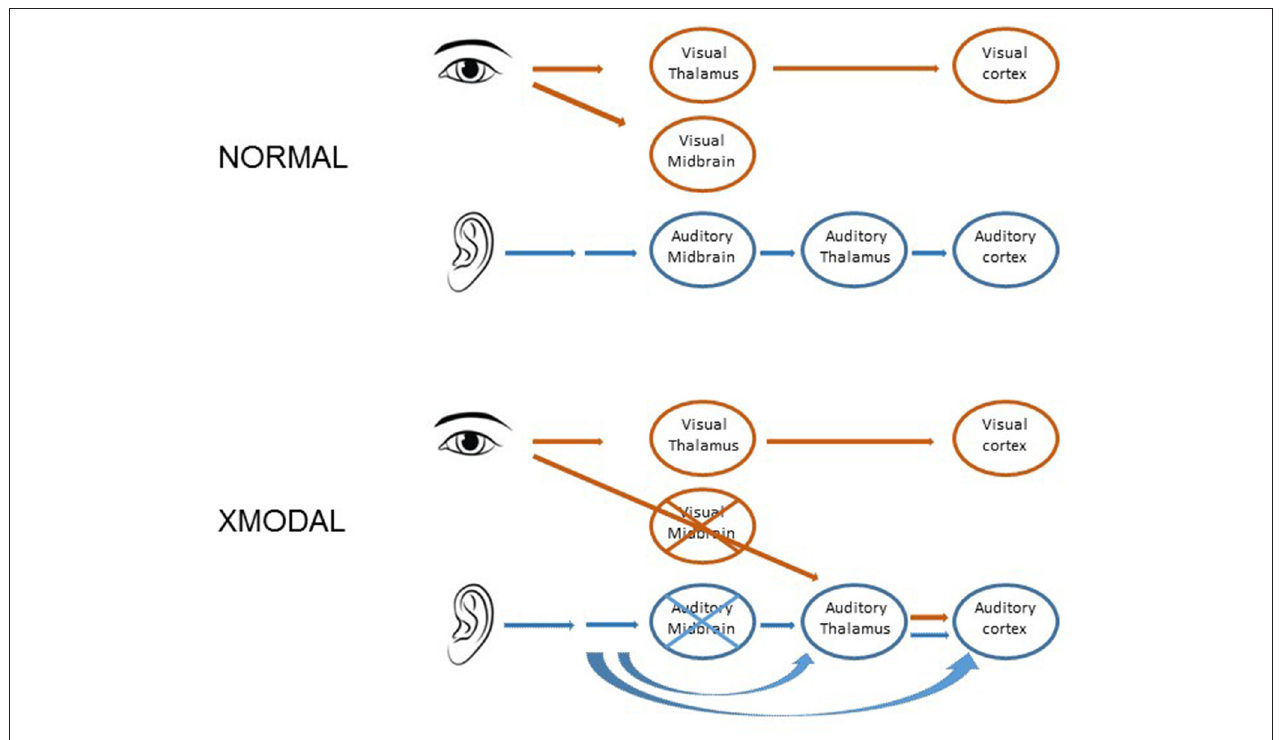
FIGURE 2 | Cartoon depicting the normal projections in the auditory and visual pathways (top) and the surgical procedure that leads to cross-modal plasticity in ferrets (bottom) . As a result of the procedure, the retina invades the auditory thalamus, which in turn conveys visual activity to the auditory cortex.